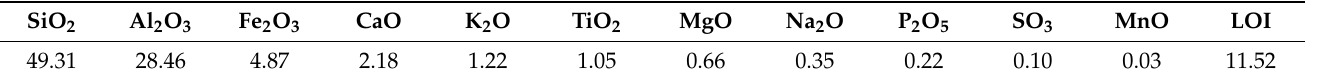
Table 1. Chemical composition of fly ash/